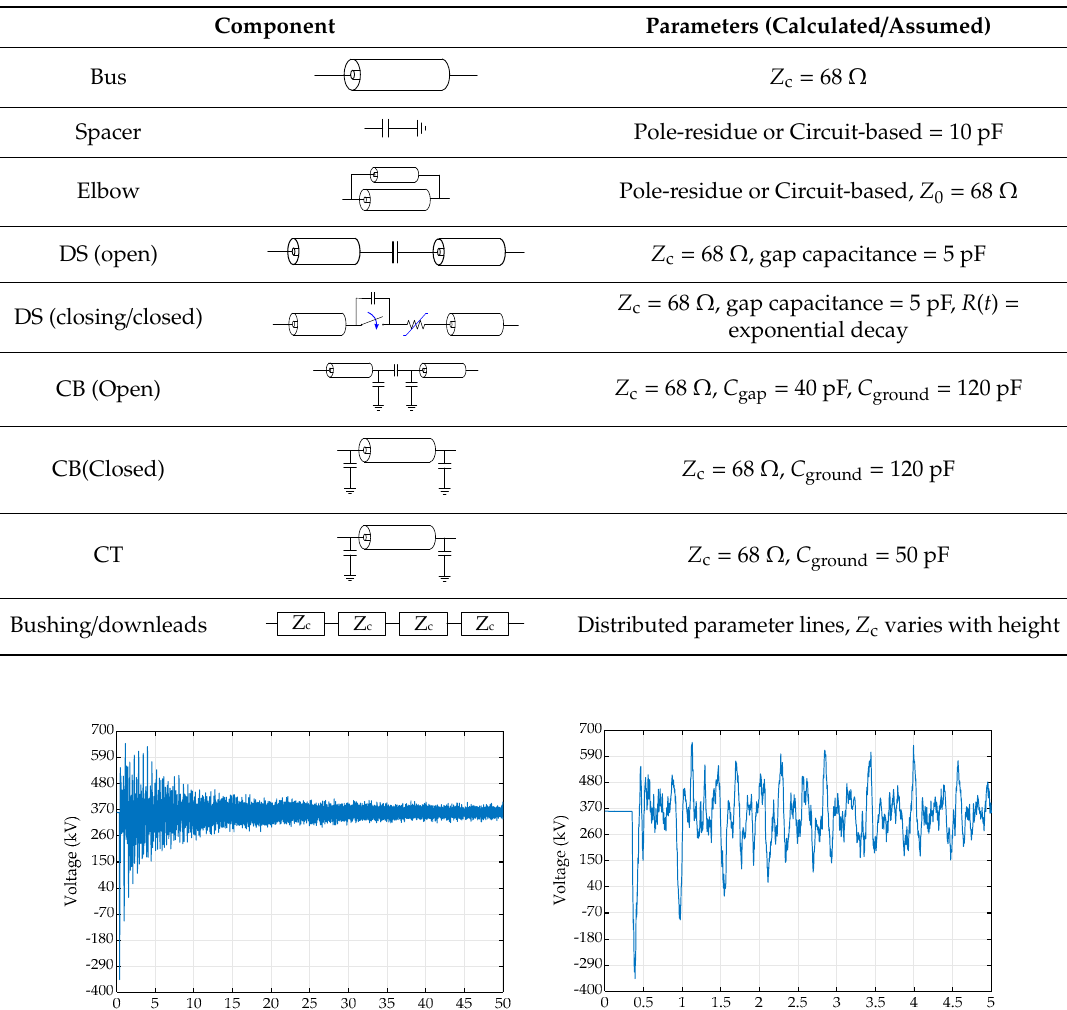
Figure 9. 400 kV system diagram. Table 3. Circuit model components.